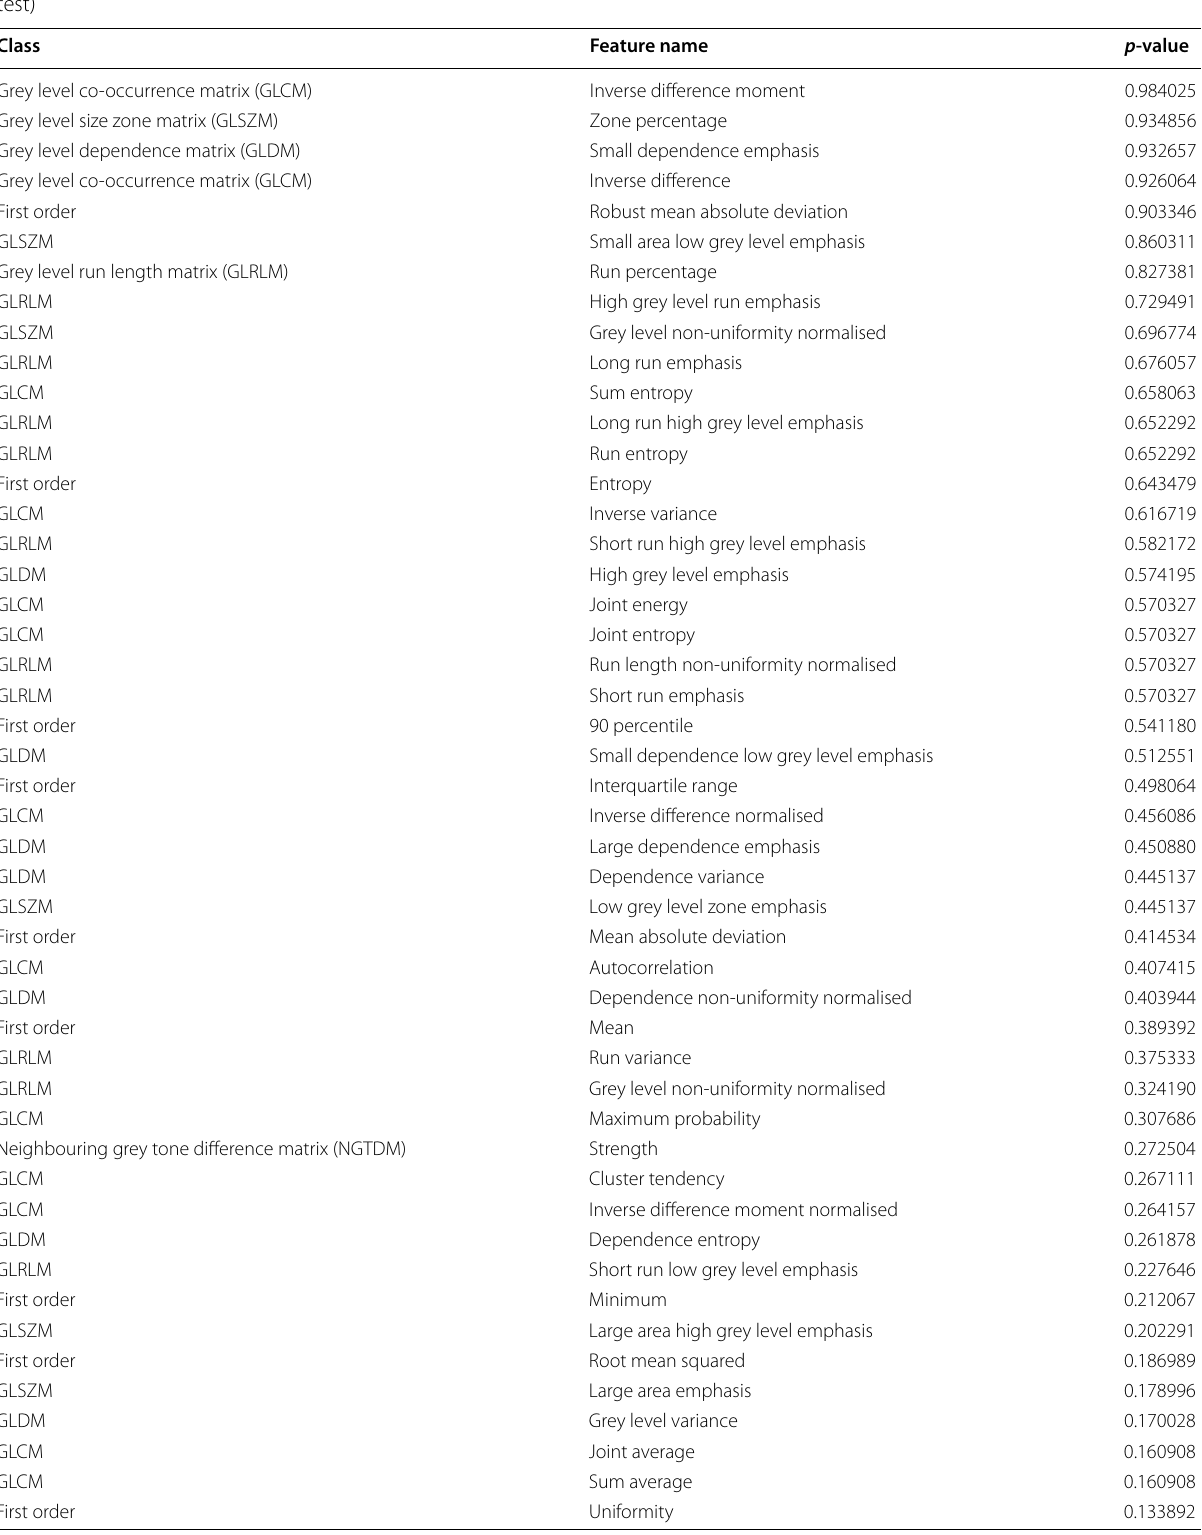
Table 1 Comparison between real and deep learning-generated radiomic features ( p -values according to the